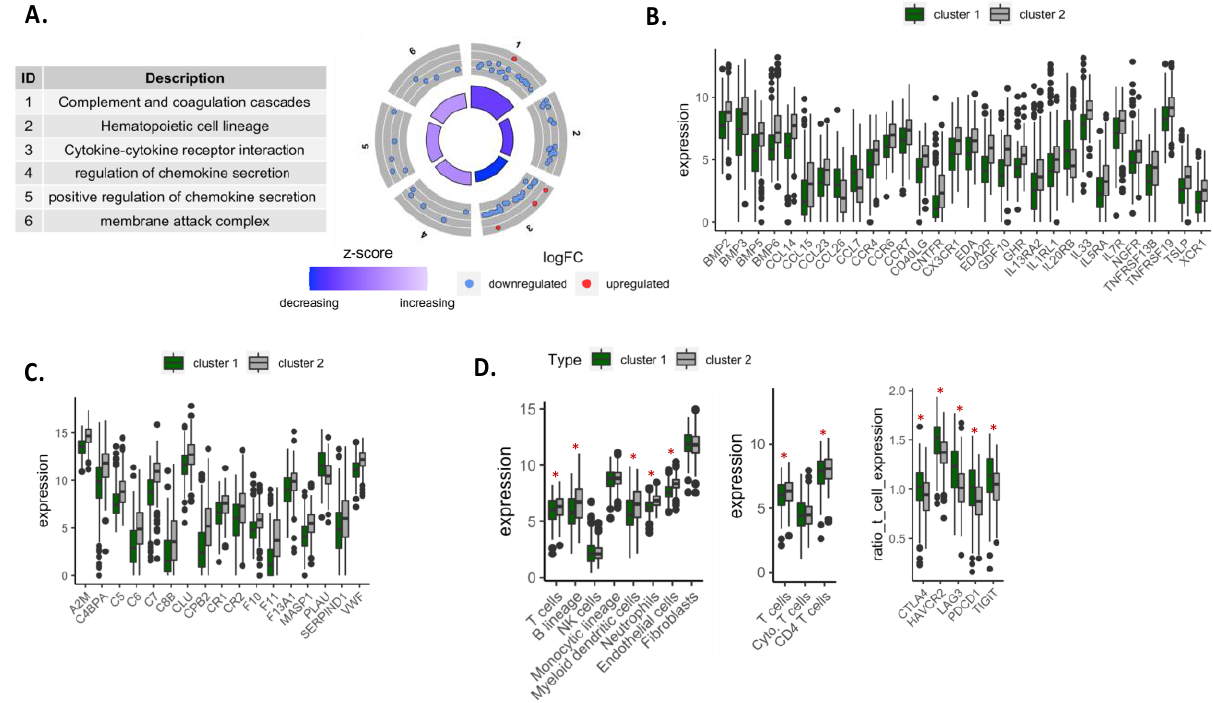
Figure 4. Enrichment analysis related to immune pathways. ( A ) Representation for gene expression in GO and KEGG enrichment analysis related to immunity. ( B , C ) Significant expression of genes involved in cytokine-cytokine receptor interaction and complement cascade, respectively. ( D ) The expression of genes related to immune cells according to MCP counter database in the TCGA-LUAD datasets. *, p -value <